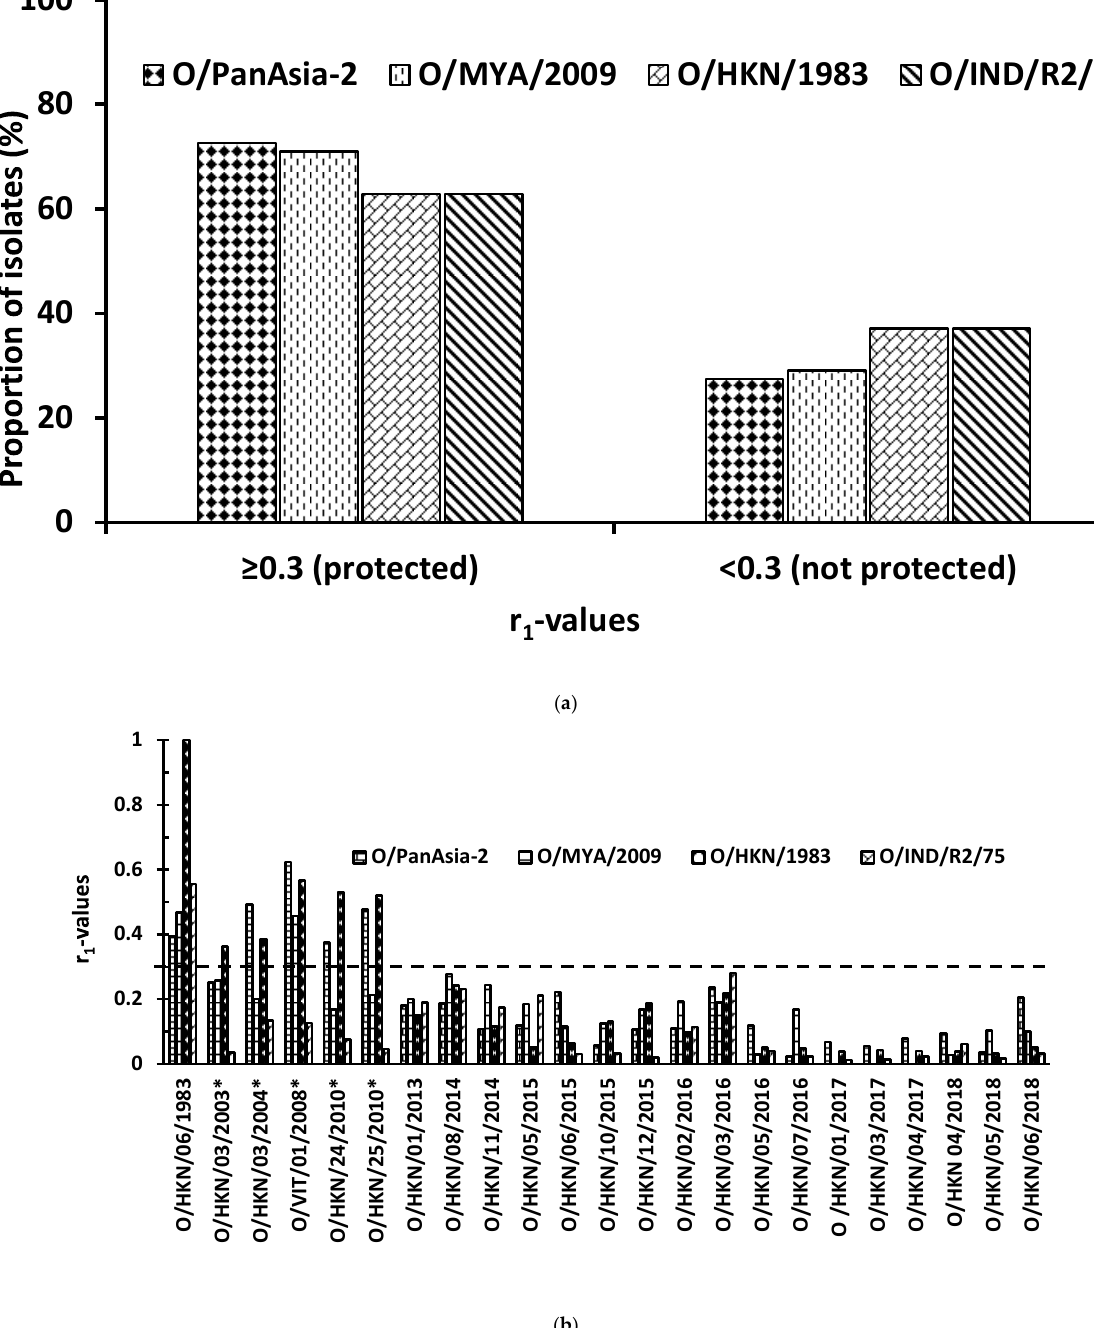
Figure 1. ( a ) Proportion of serotype O isolates (%) showing antigenic relationship (r 1 ) values against four BVS. ( b ) Antigenic relationship (r 1 ) values of serotype O/Cathay viruses against four BVS. The horizontal dotted line indicates the cut-off value of 0.3, above which the vaccine was considered to be a good match. The virus name with an asterisk at the end indicates the data taken from our previous study [12].